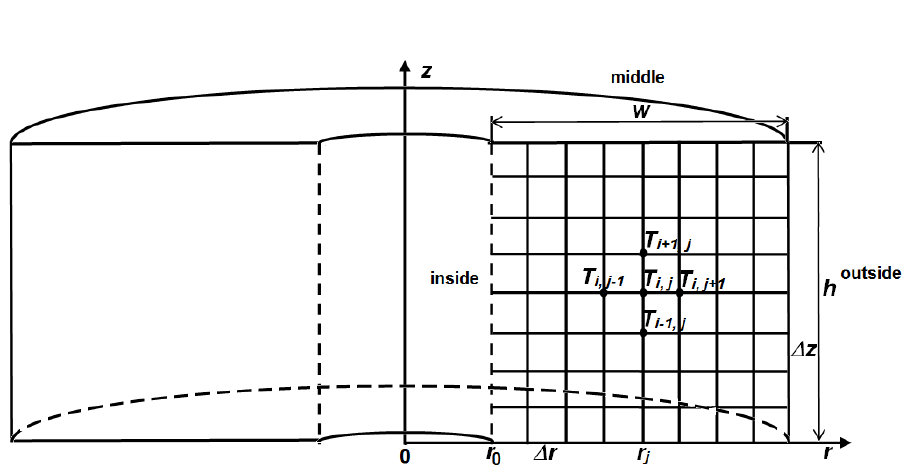
Figure 6. Division of steel coils into elementary